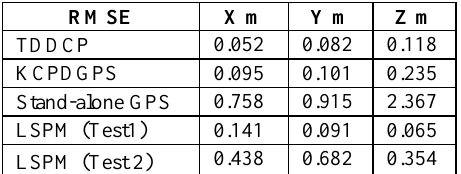
Table 3: GPS coordinates compared with the camera manual